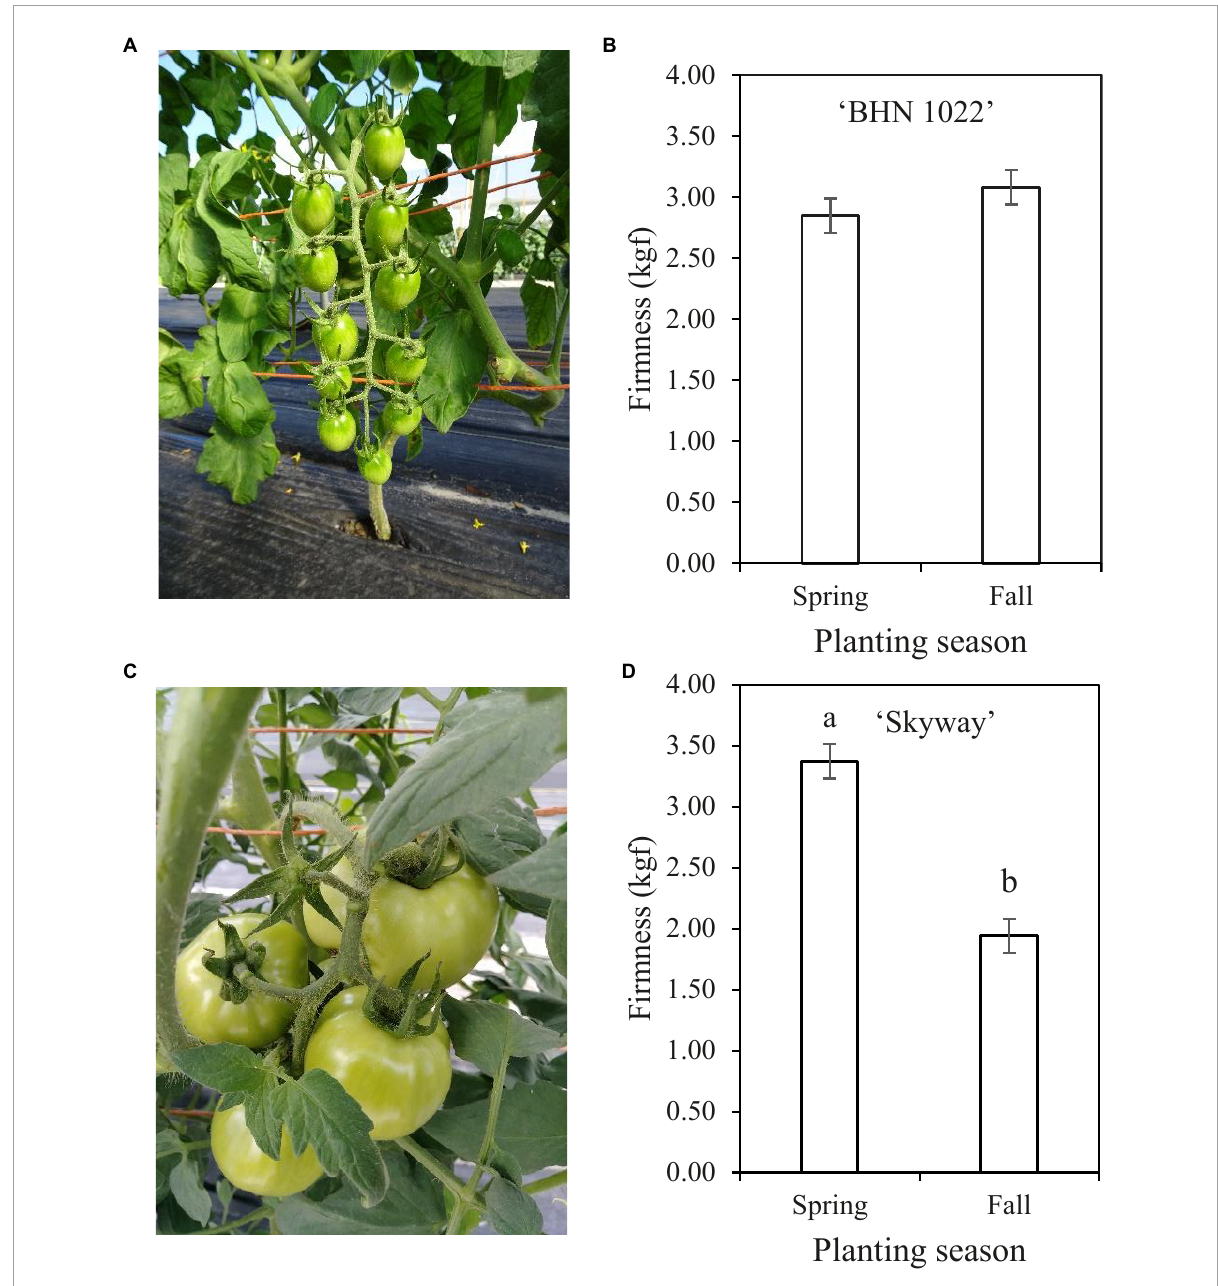
FIGURE1 Tomato fruit firmness as affected by scion × planting season interaction. (A) ‘BHN 1022’ grape tomato scion. (B) Fruit firmness of ‘BHN 1022’. (C) ‘Skyway’ beefsteak tomato scion. (D) Fruit firmness of ‘Skyway’. Error bars represent standard errors. Means followed by the same letter are not significantly different at p ≤ 0.05 according to Fisher’s LSD